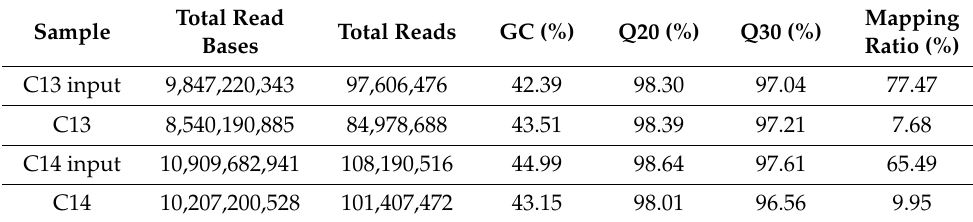
Table 1. Statistics of 8-oxoG sequencing (OG-seq)